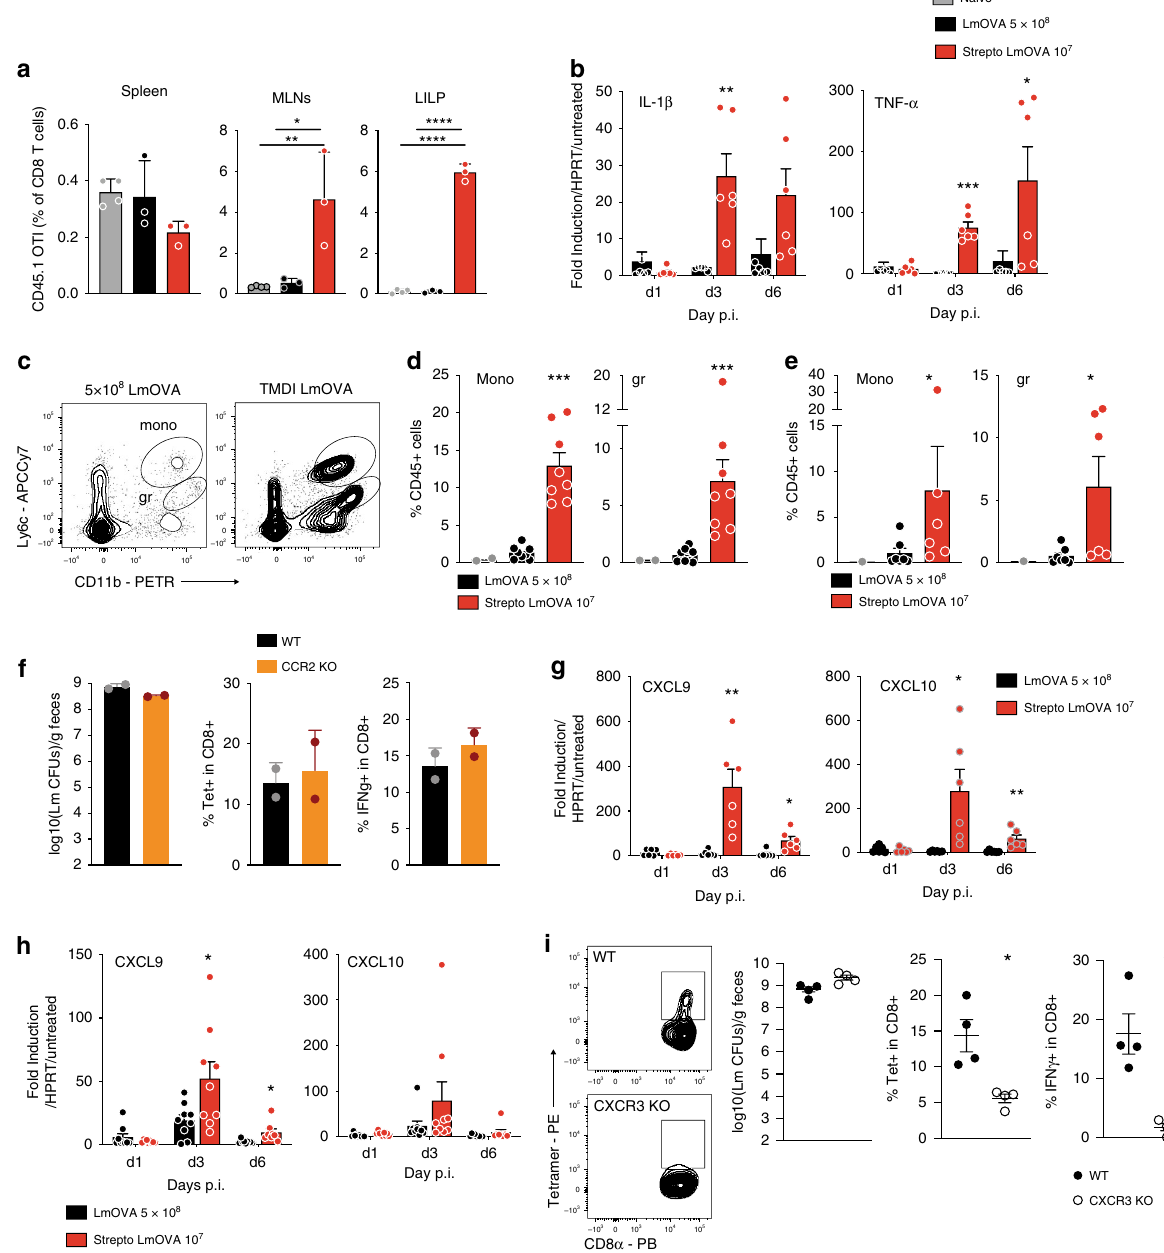
Fig. 4 TMDI promotes enhanced in fl ammation and chemotaxis through the CXCL9/CXCL10-CXCR3 axis. a Percentages of adoptively transferred OTI recovered in different tissues 4 days post immunization with the depicted strategies ( n = 4, one representative of 2 independent experiments shown; one- way ANOVA with multiple comparisons; shown are means ± SD). b qPCR quanti fi cation of in fl ammatory cytokines in the large intestine of mice immunized with standard immunization or TMDI at the depicted time points ( n = 6 from 2 experiments, shown are means ± SEM, multiple two-tailed t -test analysis). c – e Representative FACS plots ( c ) and quanti fi cation of in fl ammatory monocytes and granulocytes in the LILP ( d ) and MLNs ( e ) 2 days post immunization with the depicted strategy ( d n = 7 and e n = 8 from 3 independent experiments; n = 2 for untreated mice; shown are means ± SEM; Mann – Whitney test comparing LmOVA 5 × 10 8 and Strep + LmOVA 10 7 groups). f TMDI was performed using Δ actA LmOVA in co-housed WT and CCR2 KO mice. Shown are CFUs in fecal pellets at d1 post immunization (left, geometric means ± geometric SD), percentage of tetramer-positive cells in the LILP at d 21, and IFN- ϒ production upon ex vivo restimulation of the same cells in the presence of BFA (right) ( n = 2, one representative of 3 independent experiments shown, shown are means± SD). g , h CXCL9 and CXCL10 quanti fi cation via qPCR in the large intestine ( g ) and MLNs ( h ) of mice immunized as depicted ( n = 6, data pooled from 2 independent experiments shown, multiple two-tailed t -test analysis). i Representative FACS plots (left), CFUs in feces at day 1 p.i. (left- center, geometric means ± geometric SD), percentages of tetramer-positive cells in the LILP (right-center) and IFN- γ production upon ex vivo restimulation (right) of the same cells from TMDI ( Δ actA LmOVA)-immunized WT and CXCR3 KO mice (d21 post immunization) ( n = 4 from 2 independent experiments; shown are means± SEM; Mann – Whitney test). (For all analyses: * p < 0.05, ** p < 0.01, *** p < 0.001, **** p <